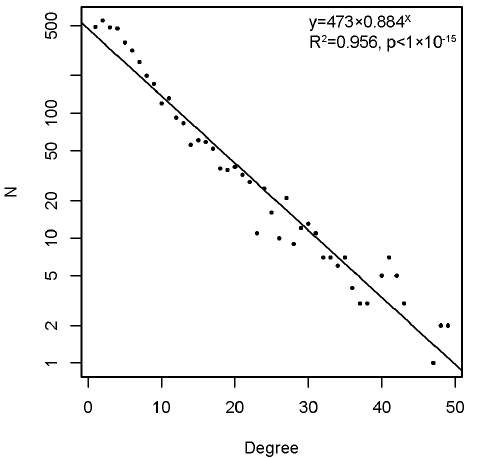
Figure 3. ( A ): ROC curve constructed on the basis of the F statistic of 4150 pairs of overlapping neighboring peptides from the studied proteins compared to a set of 10,000 pairs of dissimilar peptides selected to have a longest common subsequence of fewer than three residues. ( B ): Distributions of the logarithms of F statistic for dissimilar sequences (black) vs. overlapping sequences (red). The optimal tradeoff between sensitivity and specificity was found for F = 1 (1-specificity = 0.833, sensitivity = 0.769), but the F level of 3 was selected as a threshold (1-specificity = 0.977, sensitivity = 0.264) selecting the upper quartile of most cross-reactive pairs only.